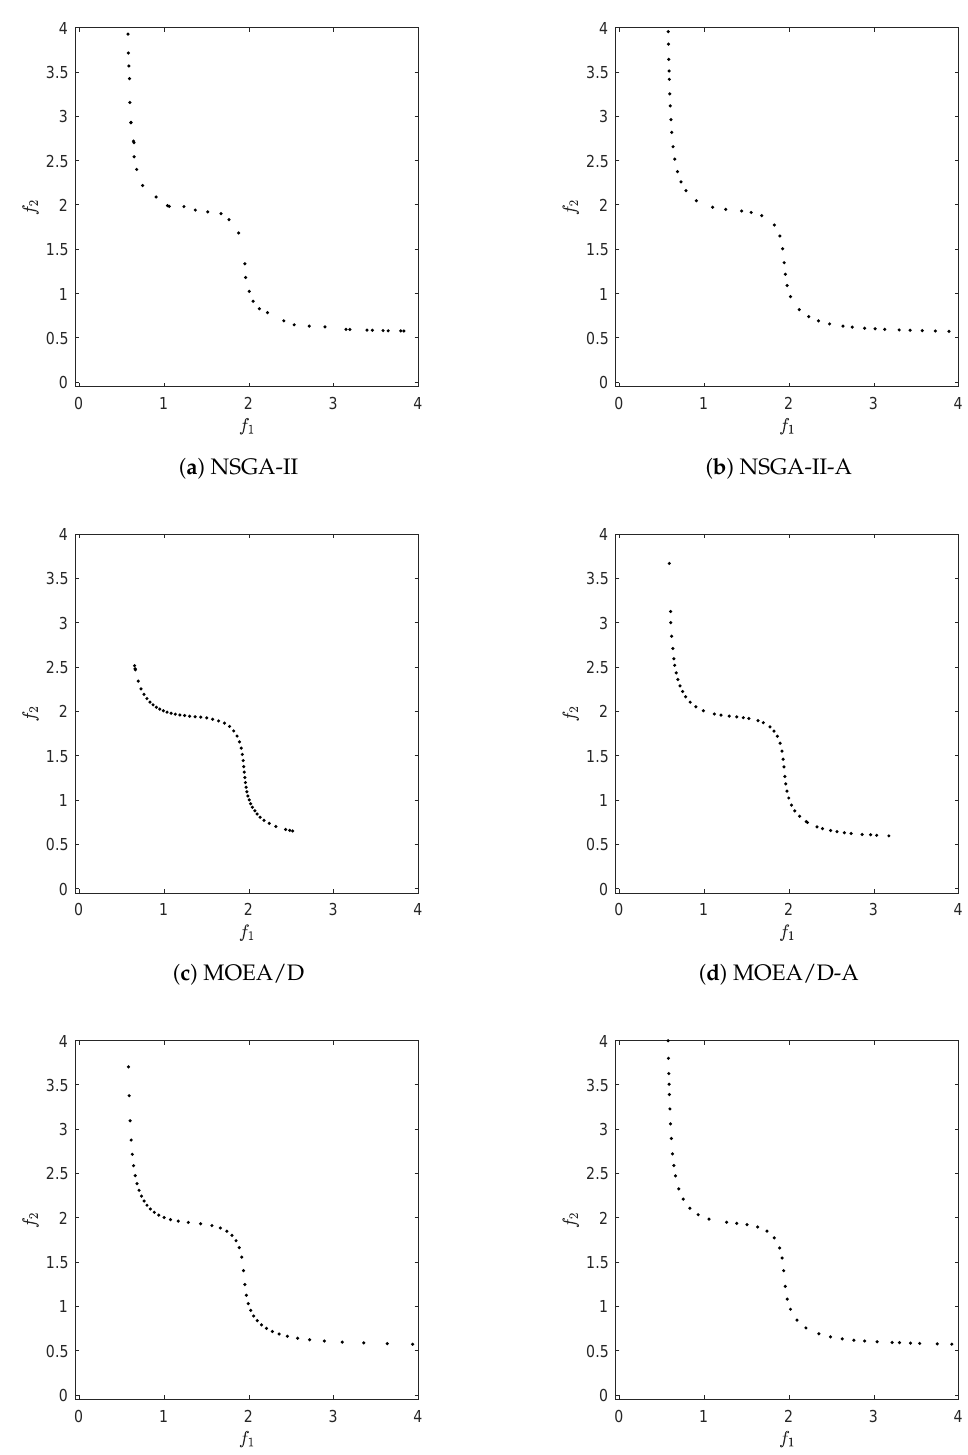
Figure A2. Numerical results of the different algorithms and archiving/selection strategies on